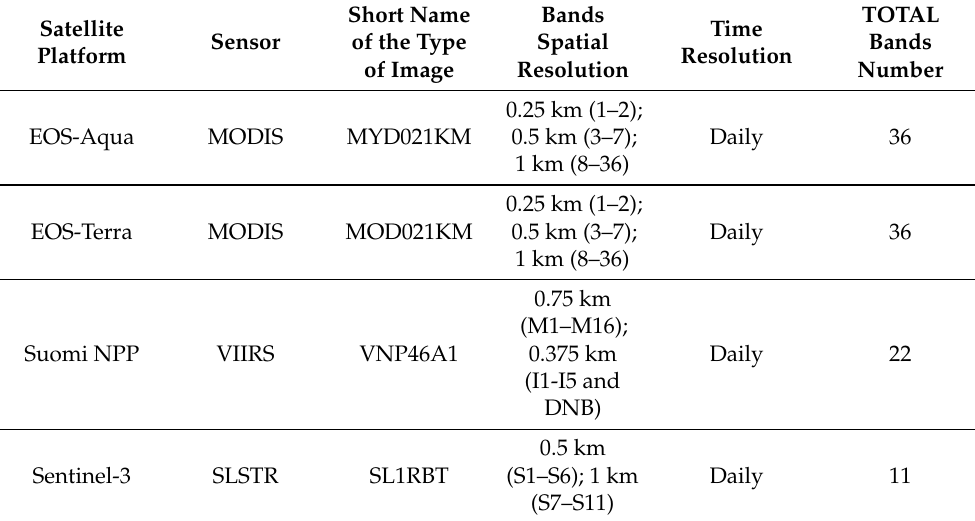
Table 1. Sensors and platforms exploited in this paper. All instruments have a global spatial coverage [31]. The numbers in brackets in the fourth column, indicate the band numbers that correspond to that spatial resolution value. Satellite Platform